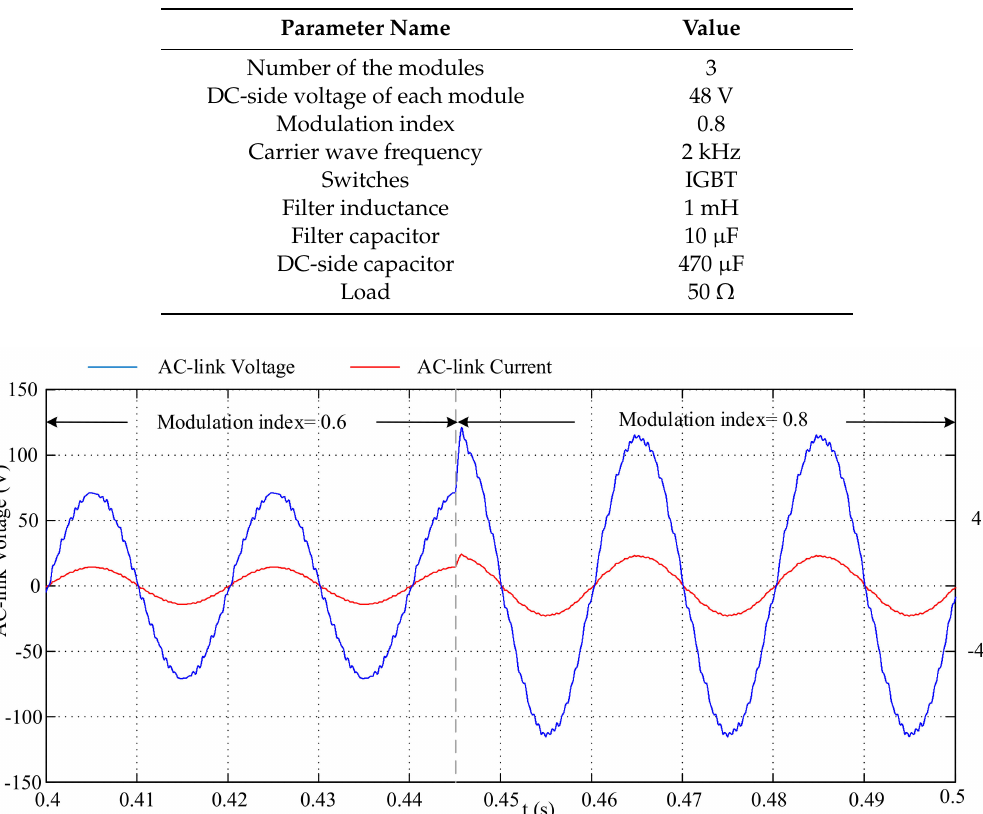
Figure 6. AC-side voltage and current for a step in the modulation index.